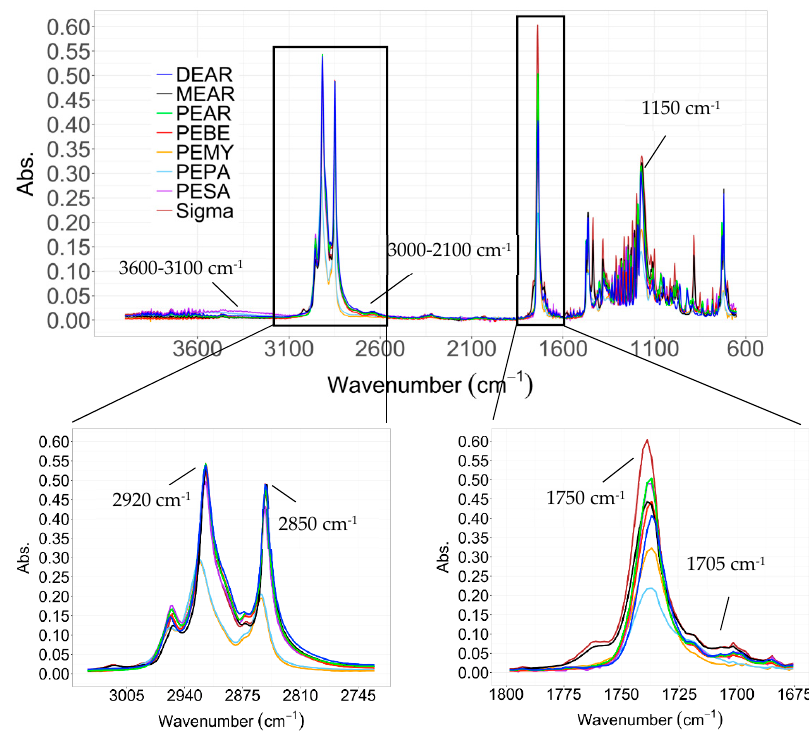
Figure 1. Attenuated total reflectance infrared spectroscopy (ATR-IR) of methyl, pentyl and decyl esters synthesized in this study compared to commercial methyl palmitate (indicated ad Sigma). The appearance of the peaks at 1750 and 1150 cm − 1 from the stretching of C=O and C-O-C in esters confirm the formation of the ester group. Impurities from unreacted alcohol or carboxylic acid would be visible at 3600–3100 and 3000–2100 cm − 1 from the stretching of free O-H in alcohols and carboxylic acids respectively, and at 1705 cm − 1 from the C=O stretching of carboxylic acids. Table 1. Retention times in min derived from the gas chromatography (GC) chromatograms measured and fragmentation patterns reported from mass spectroscopy (MS) spectra with relative intensities in brackets. The most abundant fragment is assigned a value of 100% while all other fragments’ intensities are calculated as a relative percentage of the main